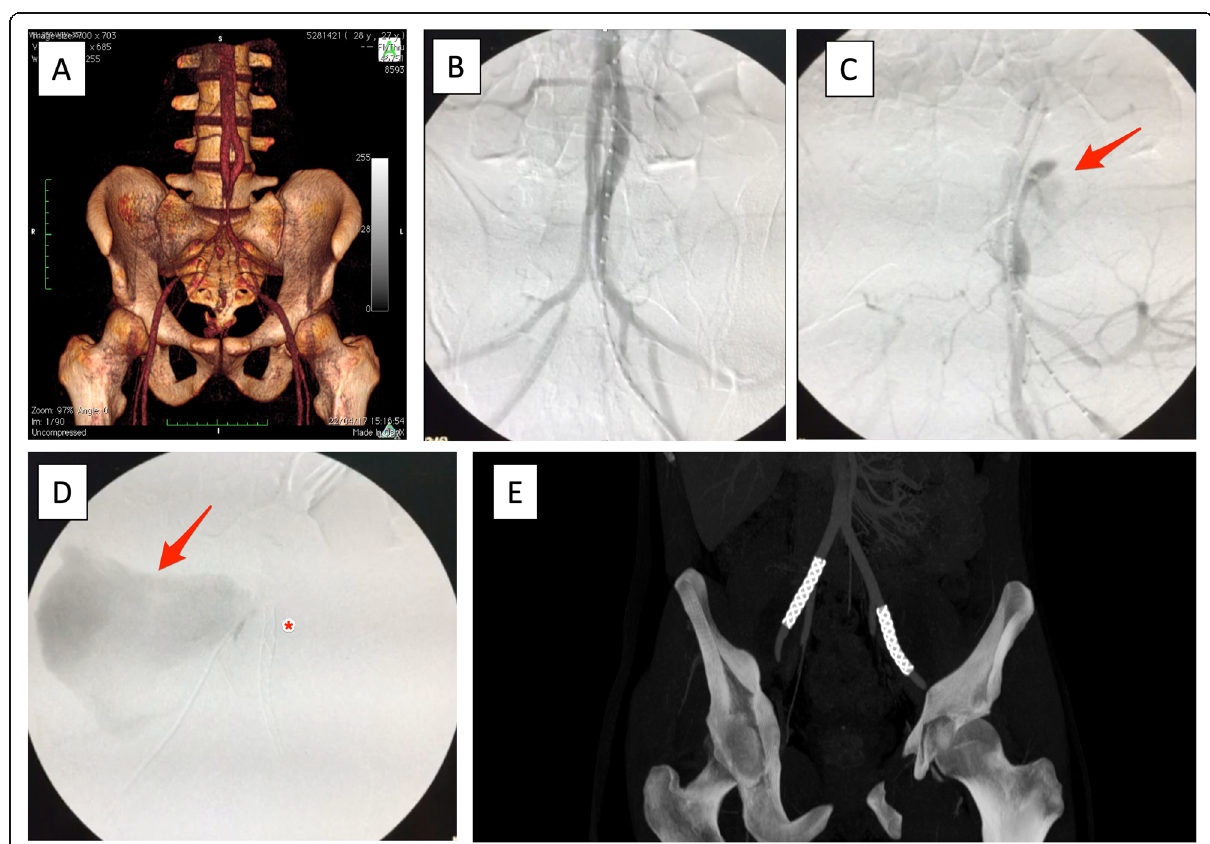
Fig. 3 A Preoperative 3D vessel reconstruction; B Intraoperative arteriogram of the iliac arteries; C Selective arteriogram of the left external iliac artery pseudoaneurysm, oblique view, arrow points the leakage; D Selective arteriogram of the right external iliac artery pseudoaneurysm showing contrast leakage (arrow) – with left endoprosthesis in place (*); E Control CT with no evidence of contrast leakage, a week